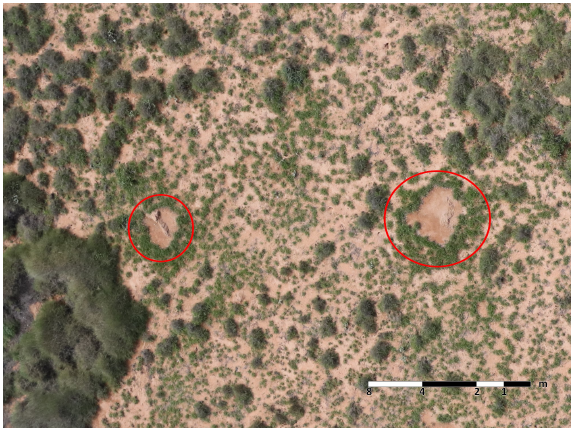
Figure 4. Highlighted pre-existing termite mounds in the planned mission route at − 22.190228 latitude, 113.865197 longitude and 68.3 m